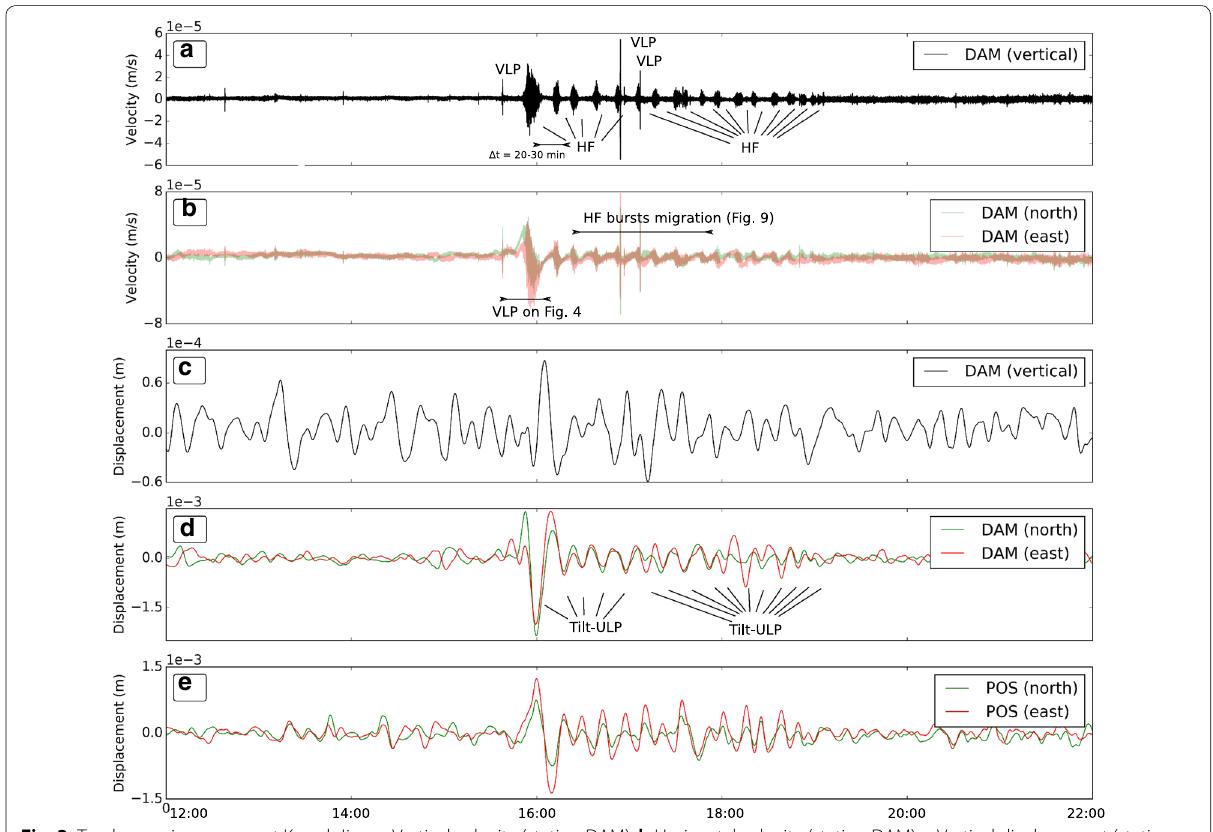
Fig. 3 Ten-hour seismograms at Kawah Ijen. a Vertical velocity (station DAM). b Horizontal velocity (station DAM). c Vertical displacement (station DAM). d Horizontal displacement (station DAM). e Horizontal displacement (station POS). For a and b , instrument responses are deconvolved after detrending and high-pass filtering the data above 0.001 Hz. The resulting ground velocity is further integrated, detrended and band-passed between 1000 and 250 s to produce c – e . The dominant period of VLP signals is 8 s with superimposed low-amplitude shorter oscillations (down to 1 s period) while the HF bursts show broadband spectra with oscillations between 1 and 20 Hz. The dominant period of the ULP tilt signals in ( d ) are oscillating between 12 and 18 min. Note that the vertical component in ( c ) is about 20 times smaller than horizontal components in ( d ) and can be barely distinguished from the background